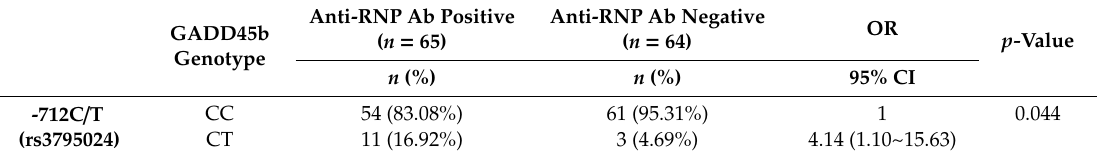
Table 5. Genotypes frequency of -712C / T, GADD45b gene in anti-RNP Ab positive and anti-RNP Ab negative SLE patients.